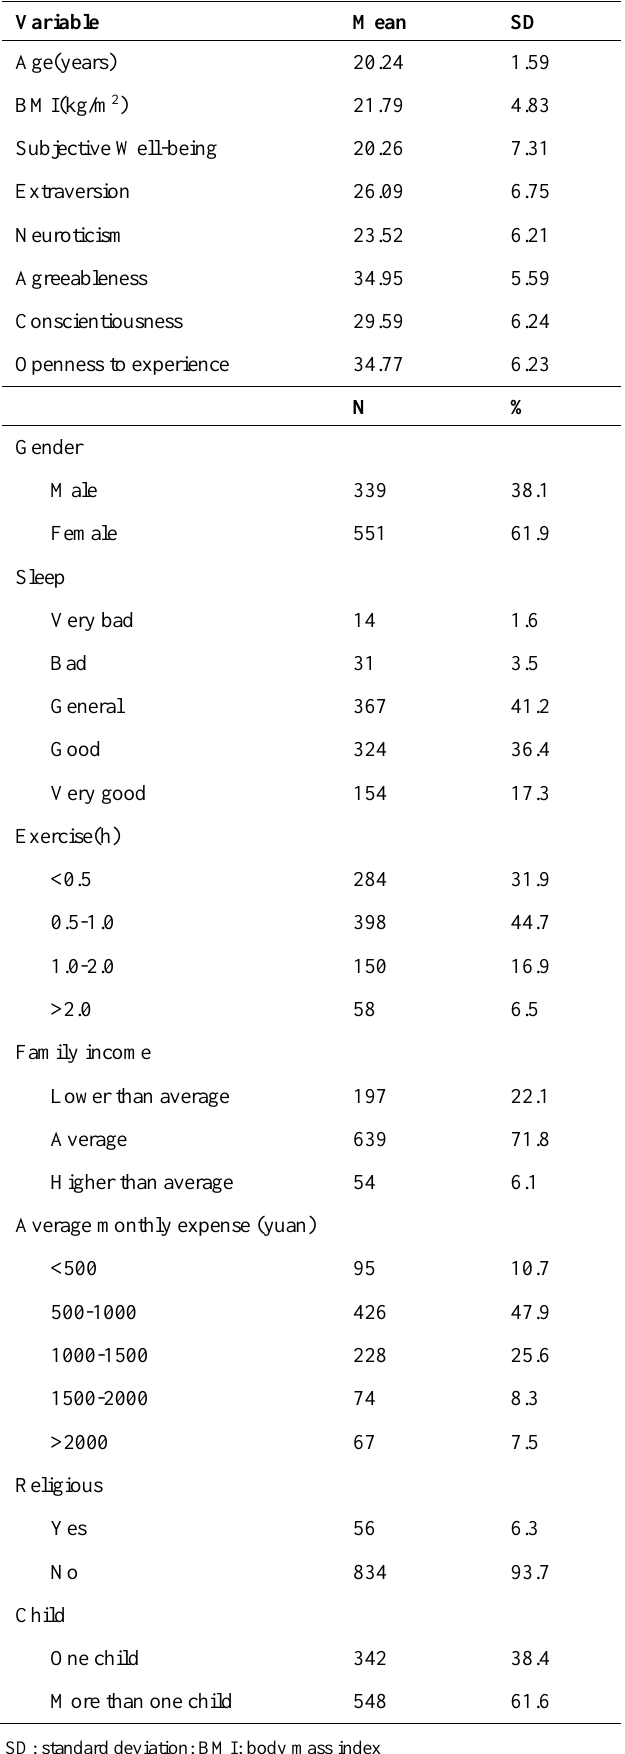
Table 2. Baseline characteristics of all 890